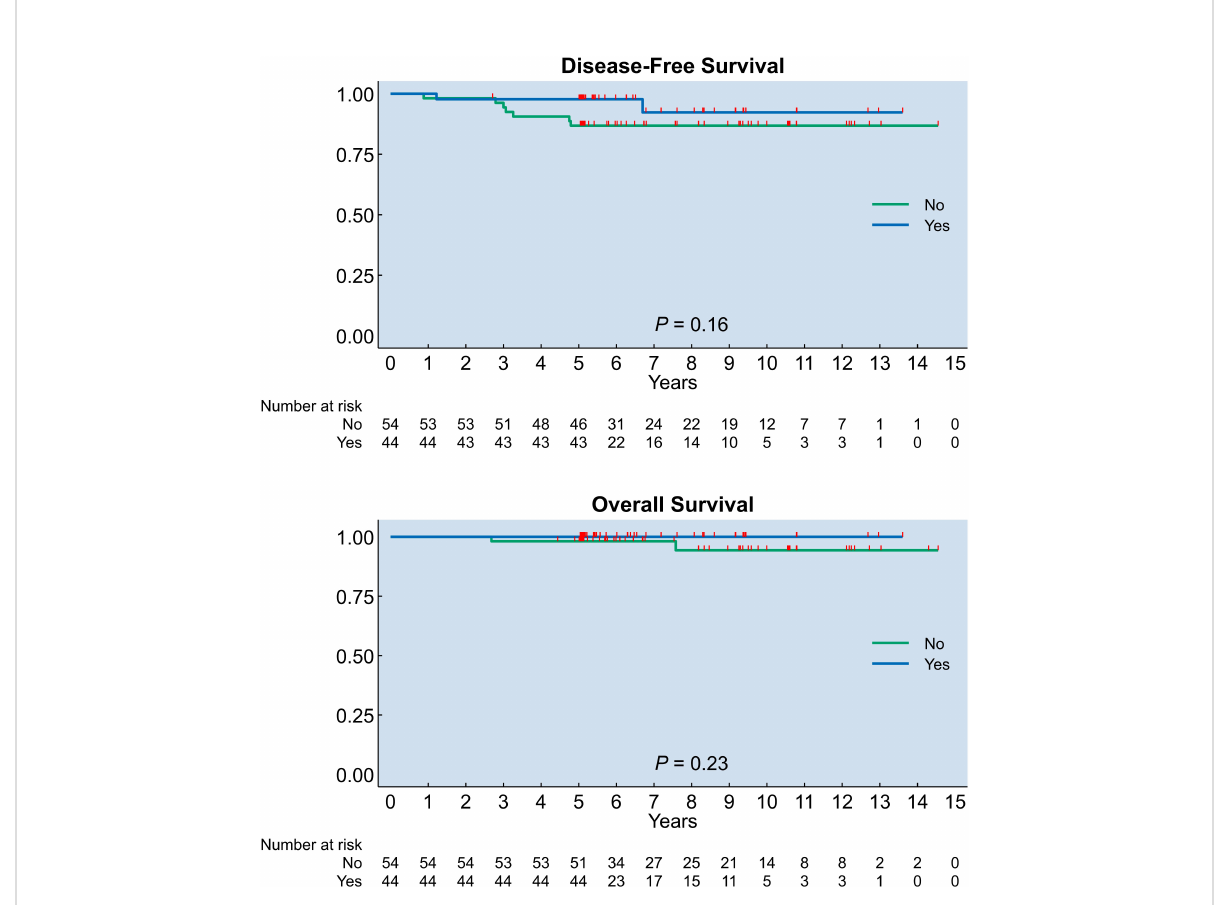
FIGURE 1 Kaplan – Meier estimates of disease-free and overall survival according to the presence of hysterectomy in the surgical treatment; censoring times are marked with red spikes. P-values for differences between groups were obtained with the log-rank